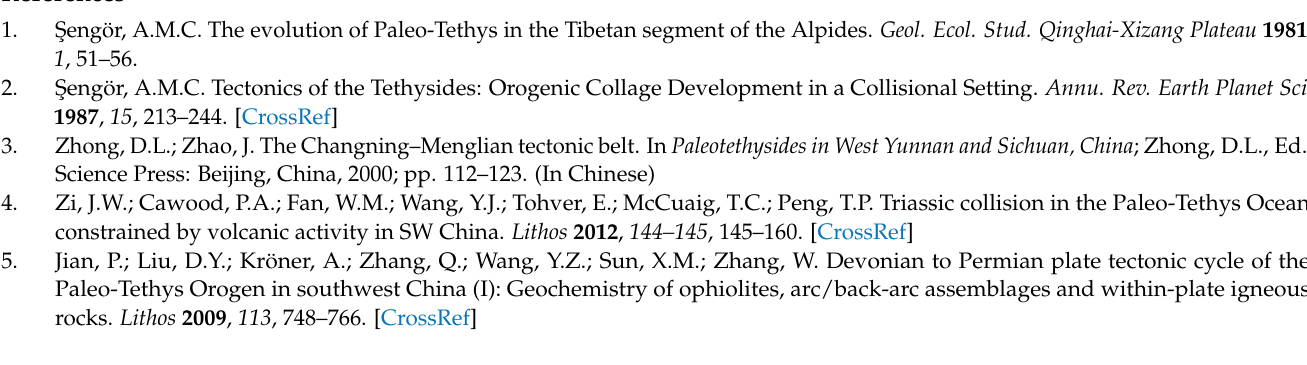
Table S9: Summary of Sr-Nd isoplot composition of mafic rocks from the JASB; Table S10: Summary of trace elements compositions of mafic rocks from the